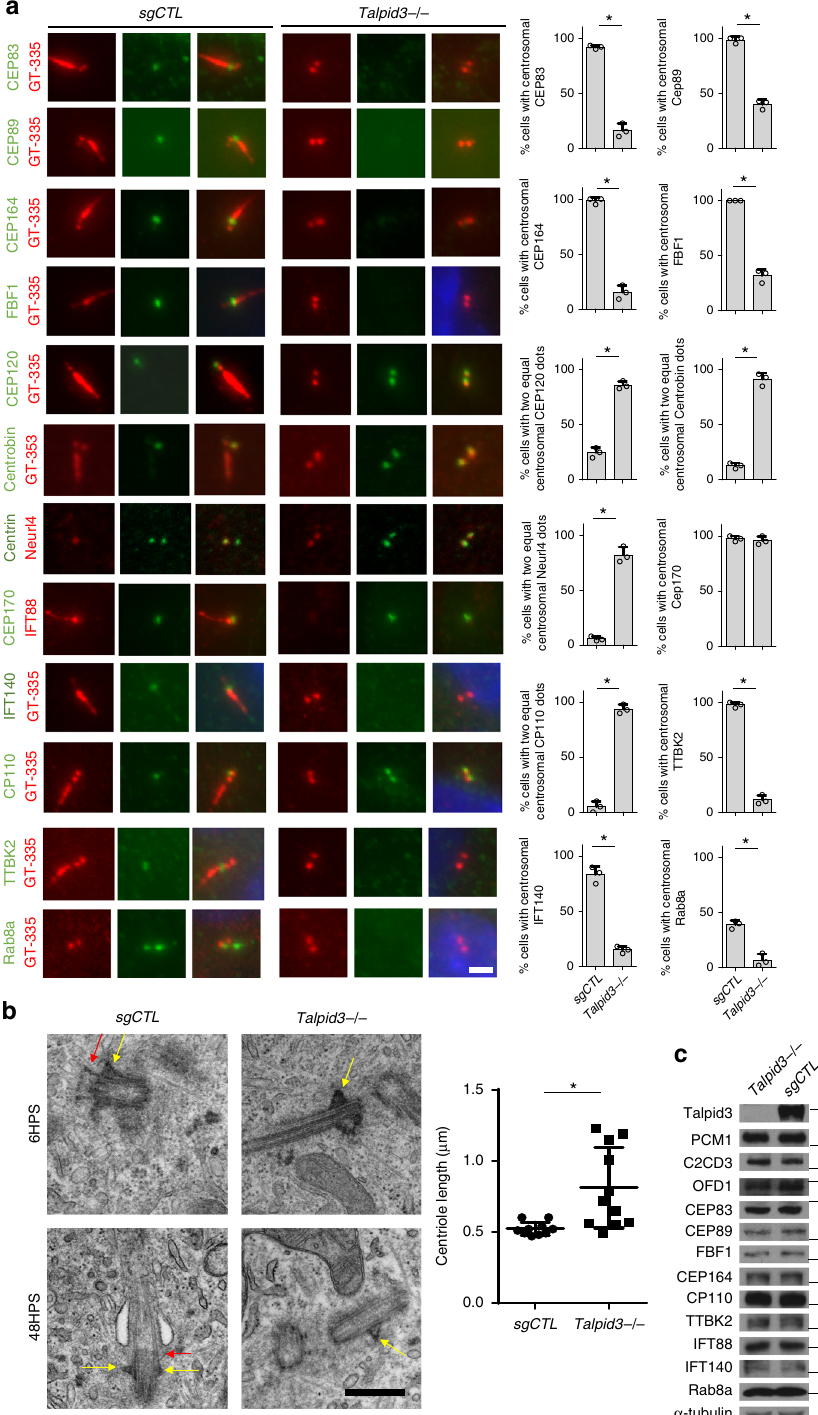
Fig. 1 Talpid3 regulates centriole maturation and vesicle docking. a Centrosomal proteins and vesicular proteins were examined in control and Talpid3 − / − cells by IF after 6 (Rab8a) or 48 h (all markers except for Rab8a) of serum-starvation using indicated antibodies. Scale bar = 2 μ m. The protein level of these markers was examined by western blot (WB) in c . Cumulative data from three independent experiments are shown. For each group, a minimum of 100 cells/experiment was averaged. b Centrosome and primary cilium structure in control and Talpid3 − / − cells was examined by transmission electron microscopy (TEM) after 6 and 48 h of serum-starvation (HPS). Red arrows indicate DA/transitional fi bers. Yellow arrows indicate SDA. Data from one experiment are shown ( N = 10 for sgCTL and N = 11 for Talpid3 − / − ). All data are presented as mean ± SD. * p < 0.05 (unpaired t -test). Scale bar = 0.5 μ